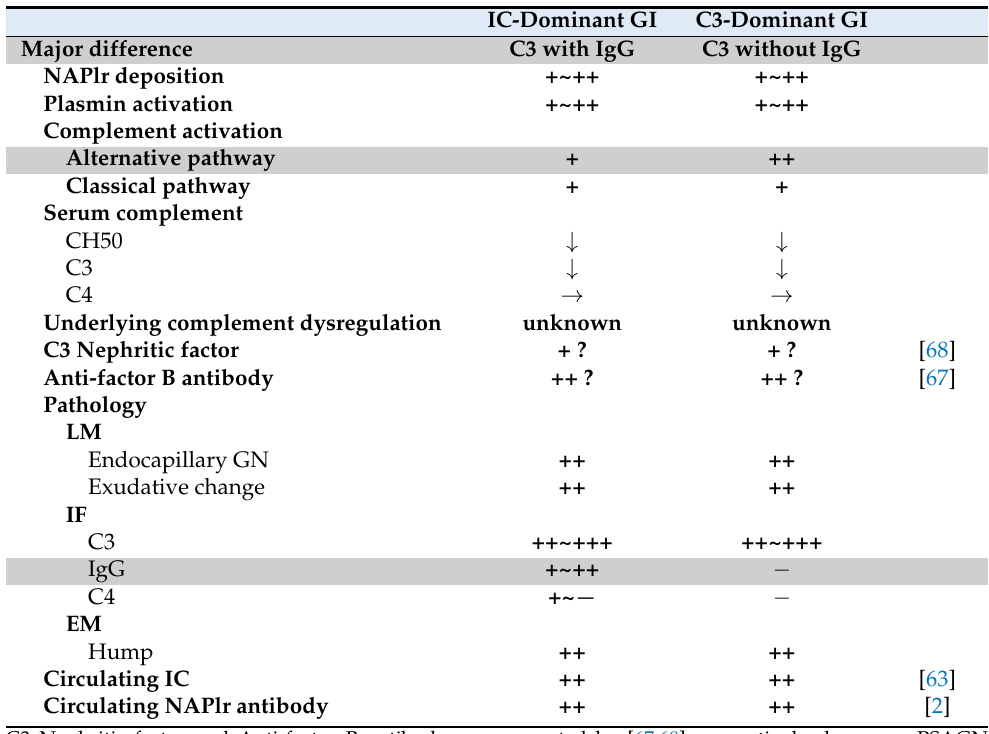
Table 4. Characteristic features of immune complex (IC)-dominant glomerular injury (GI) and C3-dominant